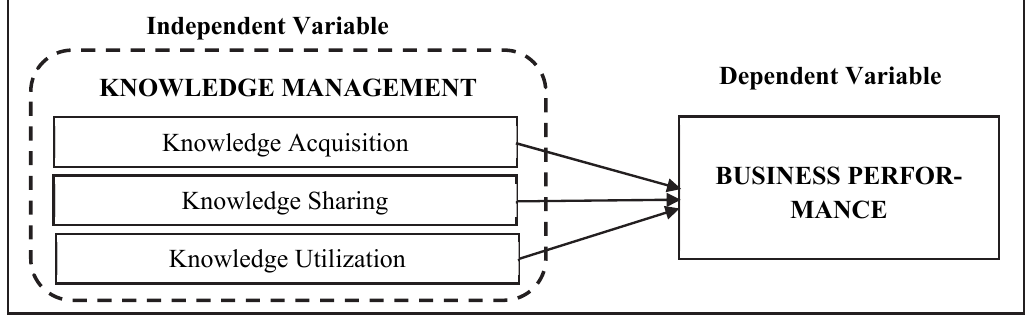
Fig. 1. Theoretical